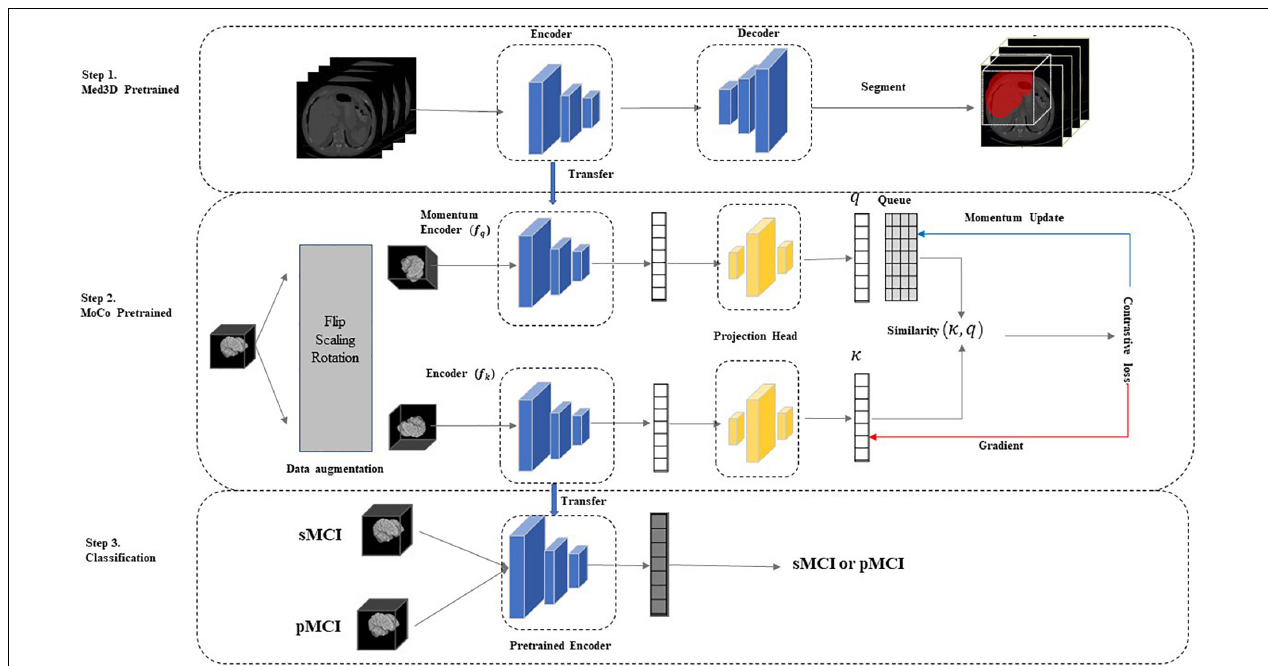
FIGURE 1 | The two-stage model. In step 1, we used the Med3D (Chen et al., 2019) pre-trained model to initialize network weights and learn the common medical image features. In step 2, we performed contrastive learning on unlabeled sMCI and pMCI samples using the improved MoCo to update the network weights, further increasing the correlation between the target and source domains and learning the specific medical features of the sMCI/pMCI classification task. Finally, the network was fine-tuned using labeled sMCI/pMCI samples to achieve sMCI and pMCI classification. MoCo, Momentum Contrast; pMCI, progressive mild cognitive impairment; sMCI, stable mild cognitive, impairment.